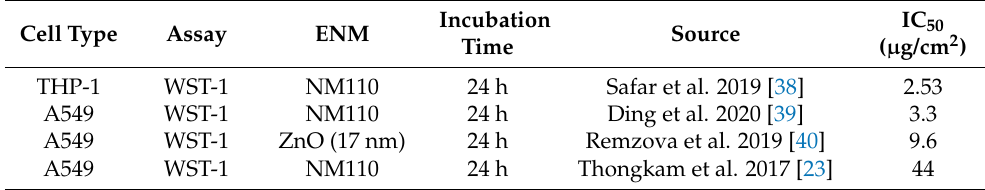
Table 3. Literature data on NM110 or ZnO ENM IC 50